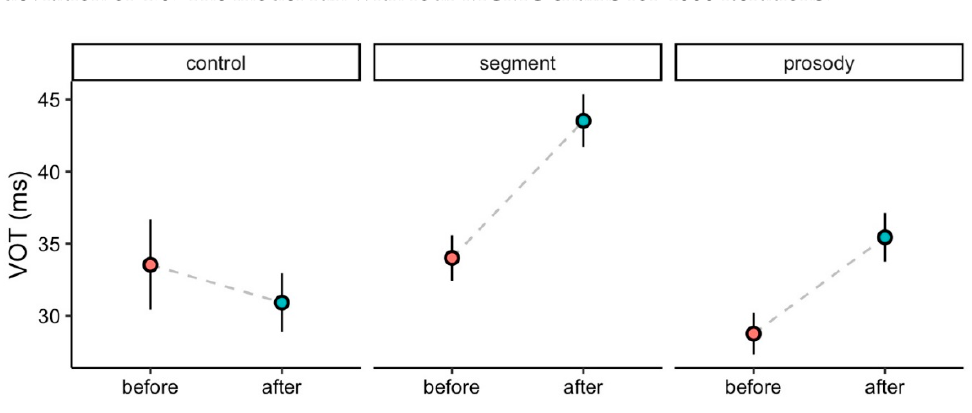
Table 12. VOT results.